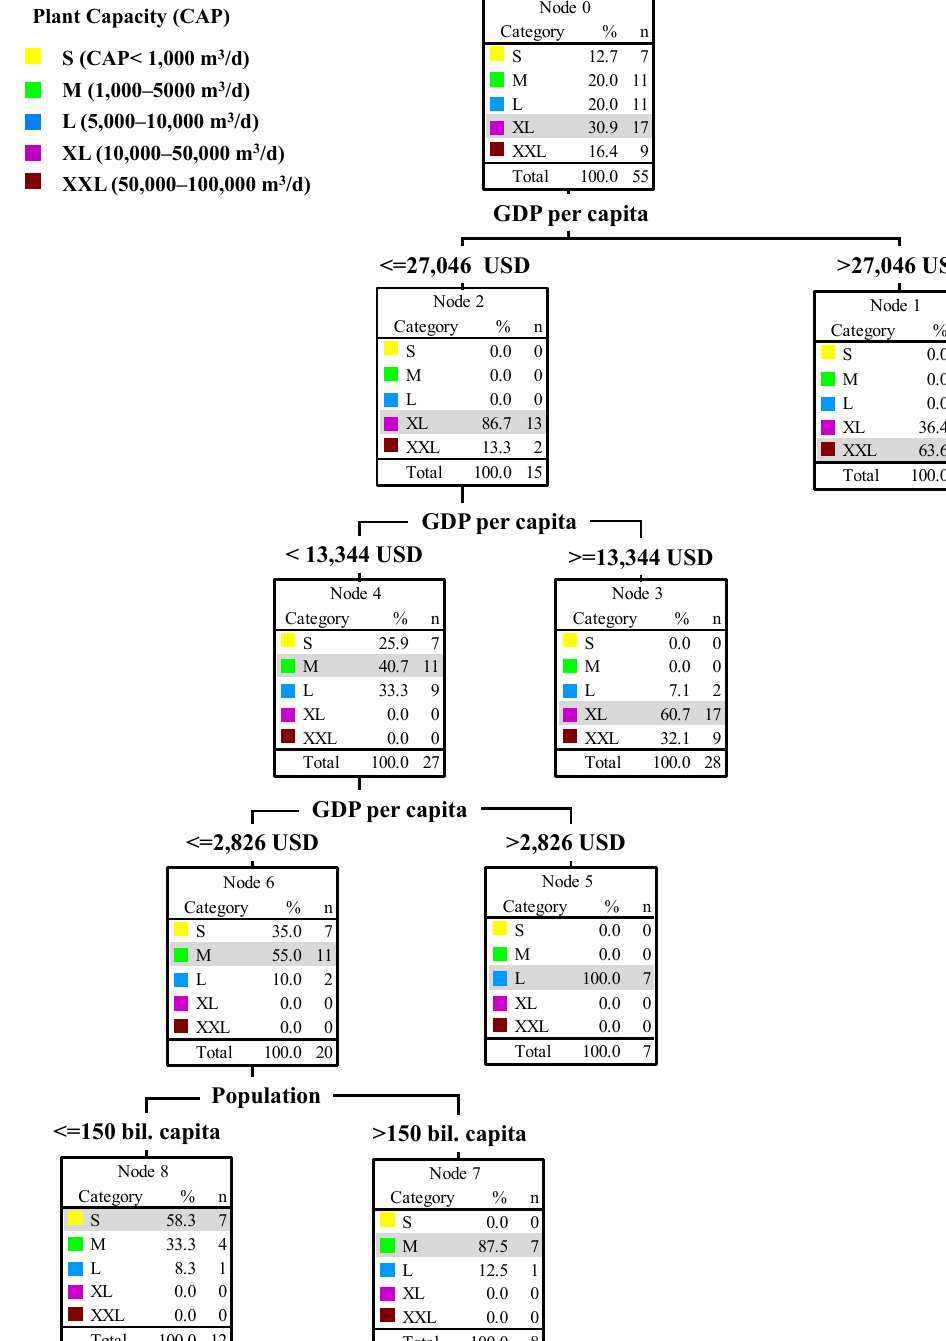
Figure 1. Decision tree of capacity selection preference for SWRO plants. Each square is a node and is labeled by a node number. In each parent node, a peak and its threshold peak height, used to divide the node into two daughter nodes, are given. For example, in node 1, the peak 13,344 USD PPP/year of GDP per capita was selected. The number (n) of cases in a node and their percentage distribution in the same capacity group are shown in each node frame.